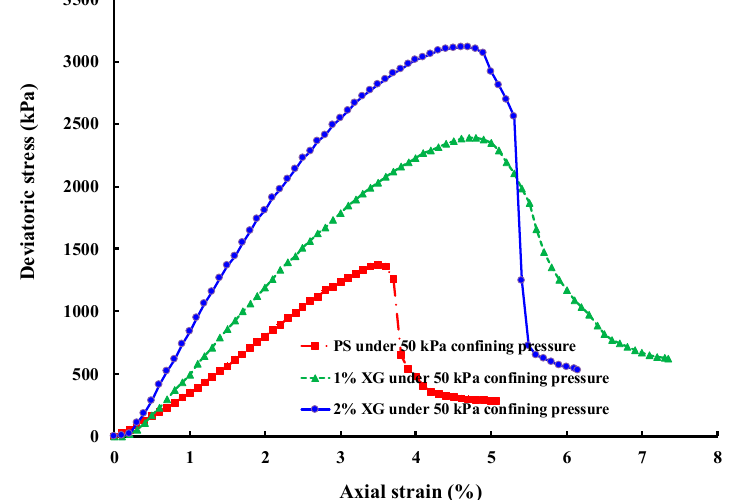
Figure 7. Results of UU triaxial test at 50 kPa confining pressure; stress–strain curves.